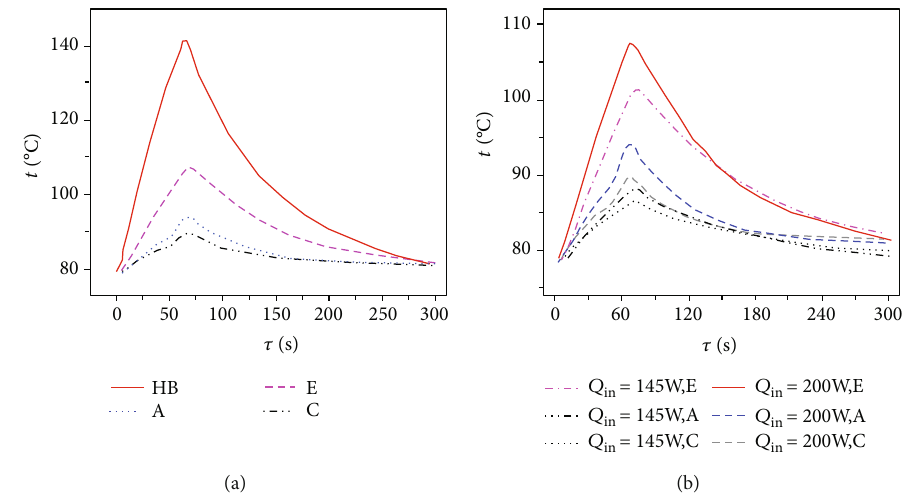
Figure 7: Behavior of thermal response: (a) transient temperature pro fi les of di ff erent parts of the bent heat pipe (HB: heating block; E: evaporation; A: adiabatic; C: condensation) and (b) e ff ect of heat input on the thermal response of the bent heat